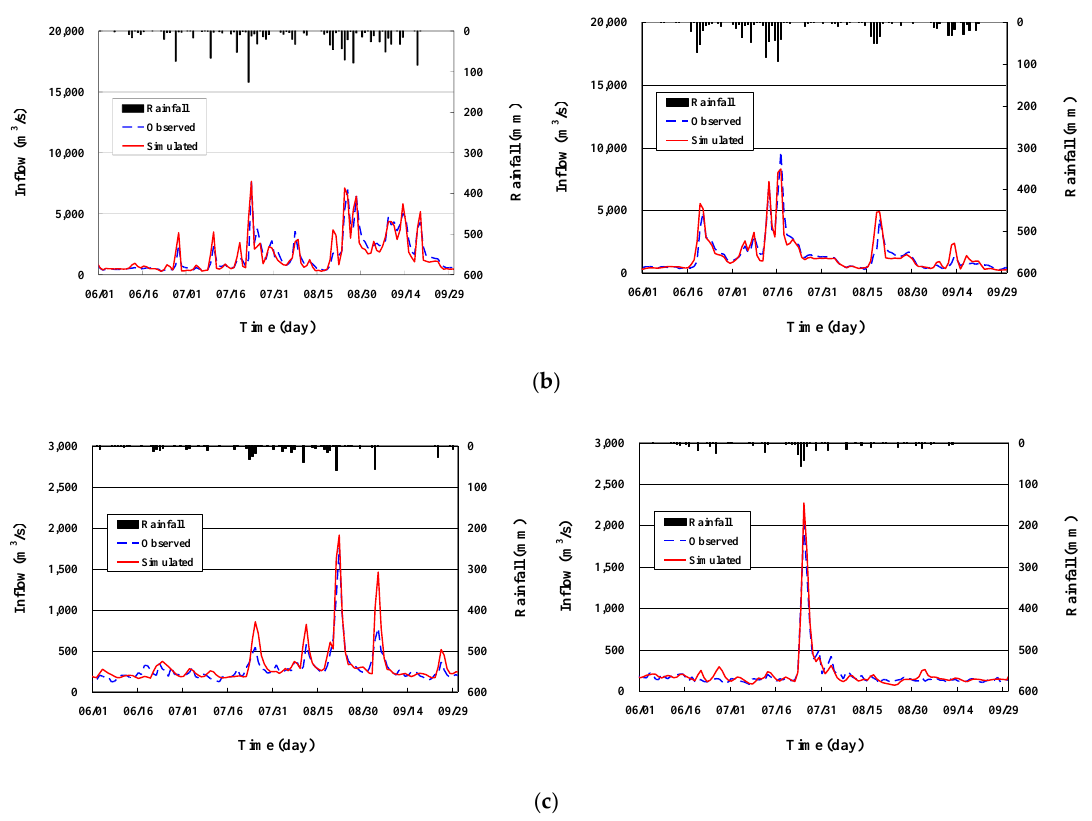
Figure 5. Observed and Simulated Daily Inflow at the Paldang Dam. ( a ) Large flood years (left: 1990, right: 1995); ( b ) Mid flood years (left: 2003, right: 2004); ( c ) Low flood years (left: 2014, right: 2015).